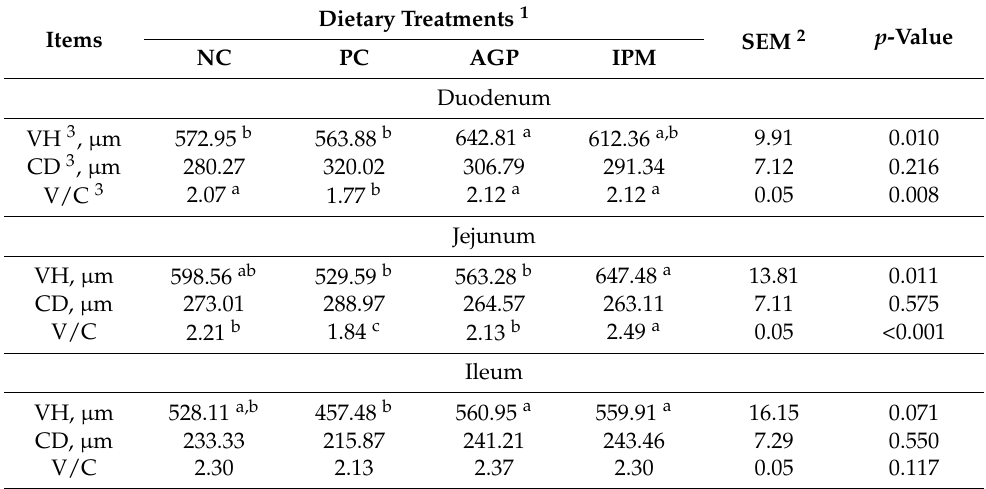
Table 5. Effect of dietary treatments on the intestinal morphology of E. coli K88-challenged weaned pigs.